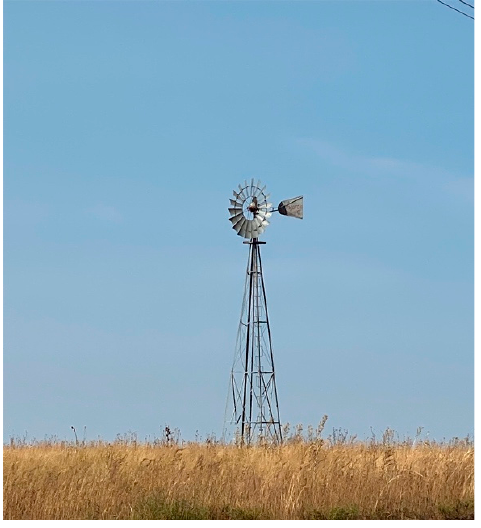
Figure 1. The Windmill well pump has greater visual contrast but also deep meaning related to cattle country of the West. (Photo by author).